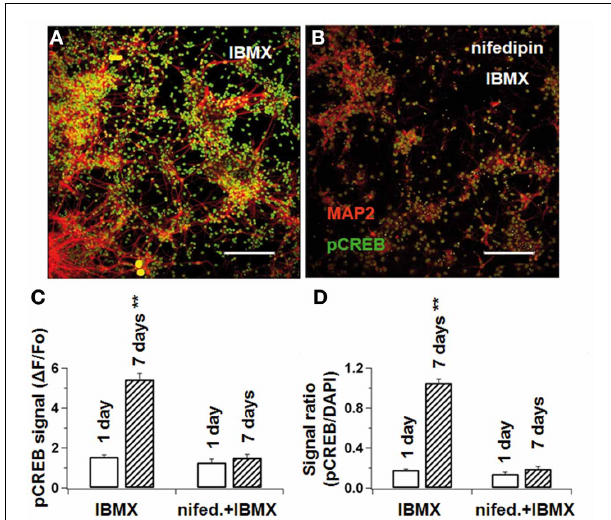
FIGURE 7 | L-type Ca 2 + -blockade prevents CREB phosphorylation in differentiating NPCs. NPCs were cultivated either under IBMX (A) or IBMX with nifedipine (B) . After 1 and 7 days, cultures were fixed and stained concomitantly for MAP2ab and phosphorylated CREB. pCREB-signal intensity was measured by confocal microscopy. In (C) , pCREB signal at the beginning and end of differentiation in cultures with IBMX and IBMX+nifedipine. In (D) , the pCREB/DAPI-signal ratio was calculated to correct for different cell densities. In both